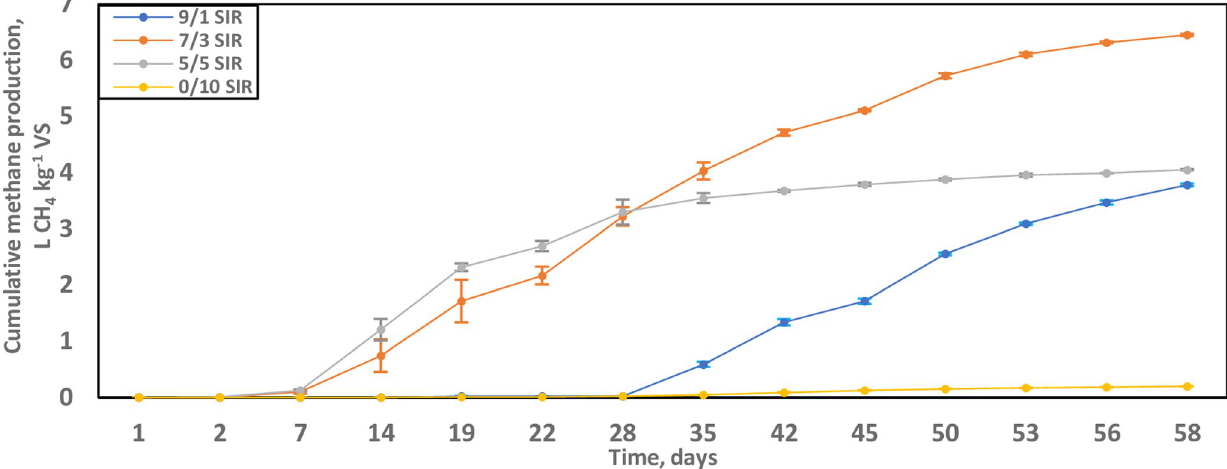
Fig 2. Cumulative methane production (L CH 4 kg -1 VS) during the co-digestion of grape marc and cheese whey at 45˚C over 58 days. The substrate- to-inoculum (S/I) ratios were 0/10 [yellow]; 5/5 [grey]; 7/3 [orange]; and 9/1 [blue]. Data are presented as averages with standard error.